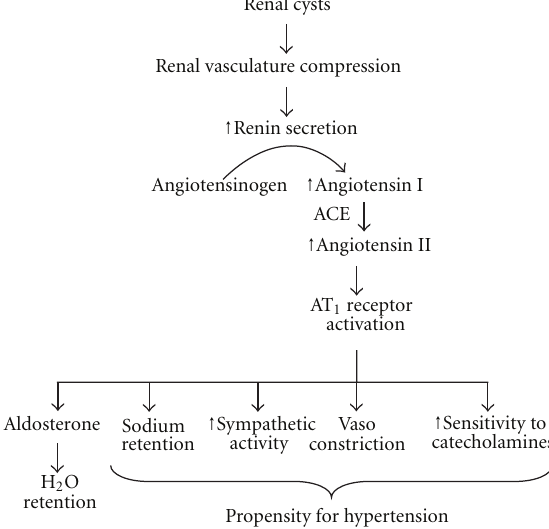
Figure 3: RAAS regulation in polycystic kidney disease. Renal cysts are thought to compress and disrupt the vascular network in the kidney. The kidney would then become ischemic, which would induce renin release from the juxtaglomerular apparatus. of angiotensinogen to angiotensin I, which is converted by angiotensin-converting enzyme (ACE) to angiotensin II. Activation of angiotensin receptor (AT 1 ) would initiate cascades of physiologi- cal responses that would lead to